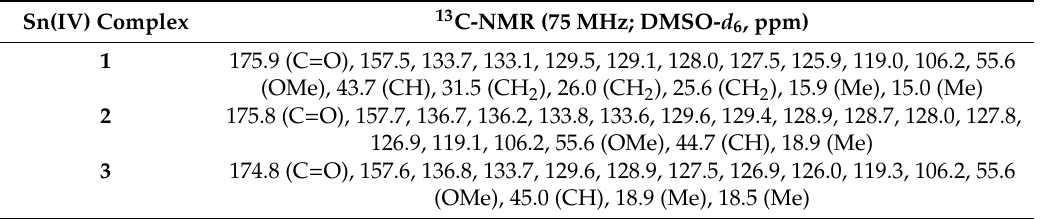
Table 4. 13 C-NMR spectral data for Sn(IV) complexes 1 – 3 .